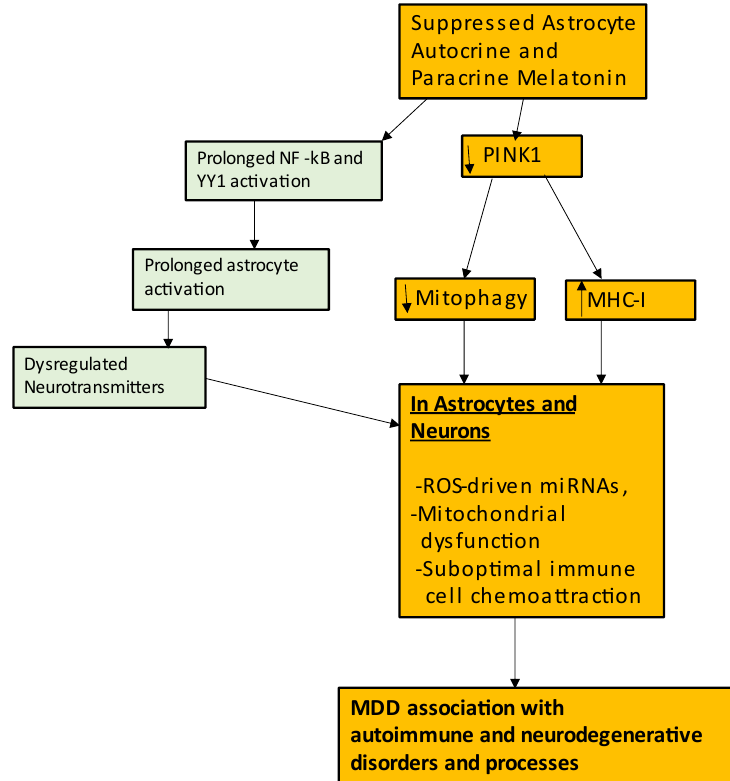
Figure 3. The suppression of astrocyte autocrine and paracrine melatonin also impacts on the regu- lation of processes associated with autoimmunity. Decreased autocrine and paracrine melatonin in astrocytes and neurons, respectively decreases mitochondrial membrane associated PINK1, leading to suppressed mitophagy of dysfunctional mitochondria and increased MHC-1. The associated increase in ROS alters patterned miRNAs and gene expressions, leaving cells more vulnerable to chal- lenge. This may include alterations in the chemoattraction of immune cells. The astrocyte melaton- ergic pathway may therefore also be a major mediator of the association of MDD with autoimmune disorders as well as with autoimmune processes, such as MHC-1, which is highly expressed in the MDD brain. Abbreviations: MHC-I: major histocompatibility complex class I; NF-kB: nuclear factor kappa-light-chain-enhancer of activated B cells; PINK1: PTEN-induced kinase 1; ROS: reactive oxy- gen species; YY1: yin yang 1. The emerging importance of astrocytes in determining coordinated CNS function and the interface with wider systemic processes via the BBB, would indicate that core pro- cesses in astrocyte function are likely to be an integral aspect of understanding brain func- tion. This article highlights how many of the diverse pathophysiological changes in many cells in MDD patients can involve alterations the regulation of the mitochondrial mela- tonergic pathway, including in CNS and systemic cells, with an array of diverse conse- quences. However, it is likely that astrocytes, as a core hub that integrates diverse CNS processes, coupled to their capacity to regulate neuronal activity and survival, as well as neurotransmitter release, oxidant and inflammatory challenges, will be an important treatment target for MDD and an array of wider medical conditions to which MDD is pathophysiologically associated. This has a number of future research and treatment implications.